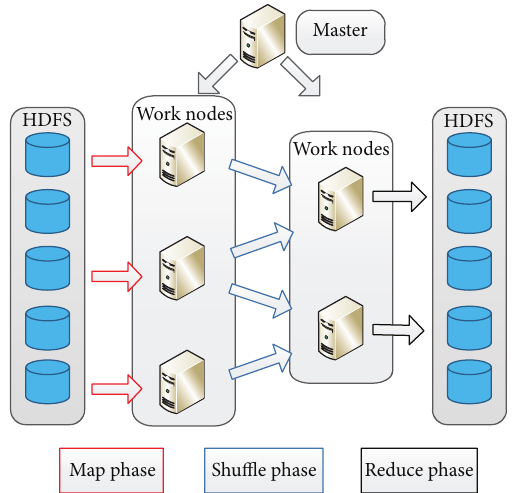
Figure 1: MapReduce computation framework that the job is split to two kinds of tasks, Map and Reduce. Different tasks are nearly independent so that different tasks can be executed in a parallel